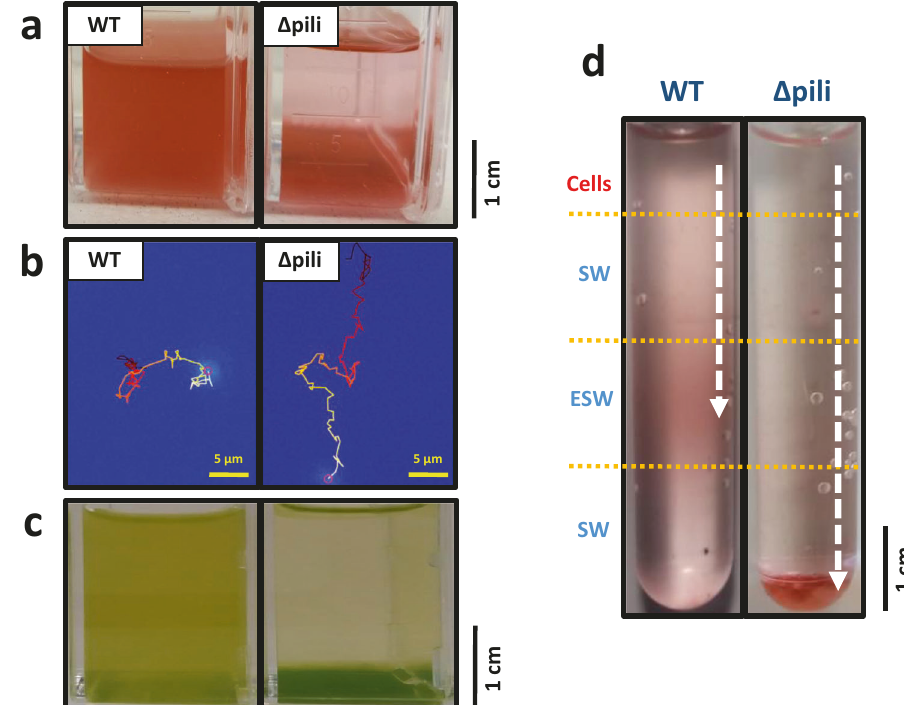
Fig. 4 Pili avoid sinking in planktonic marine picocyanobacteria. a Non-shaken cultures of wild-type (WT) and pili mutant ( Δ pili) Synechococcus sp. WH7803. The pili mutation and phenotype has proven very stable with the mutant strain unable to remain in a planktonic form when not shaken. The appearance of the mutant in the image is consistently achieved after 3 – 4 days of no shaking. b Example of a tracked suspended cell from a wild-type and pili mutant culture of Synechococcus sp. WH7803. The movement was tracked over 100 s and movement is indicated from dark red (start) to yellow (end). Full data of all tracked cells can be found in Supplementary Data 2 ( n = 2614 WT and n = 439 pili mutant cells) and examples in Supplementary